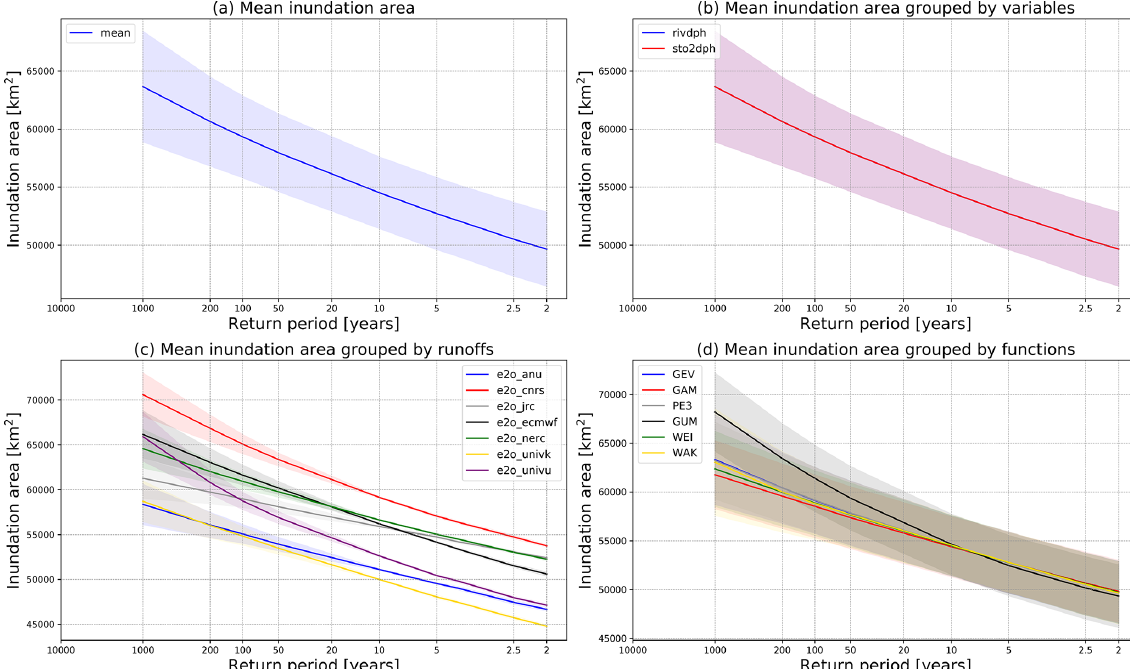
Figure 7. The uncertainties in the estimated inundation area for the study area: (a) shows the mean inundation area and the overall uncertainty; (b–d) show the mean and uncertainty in different groups by variables, runoff inputs and the fitting functions, respectively.